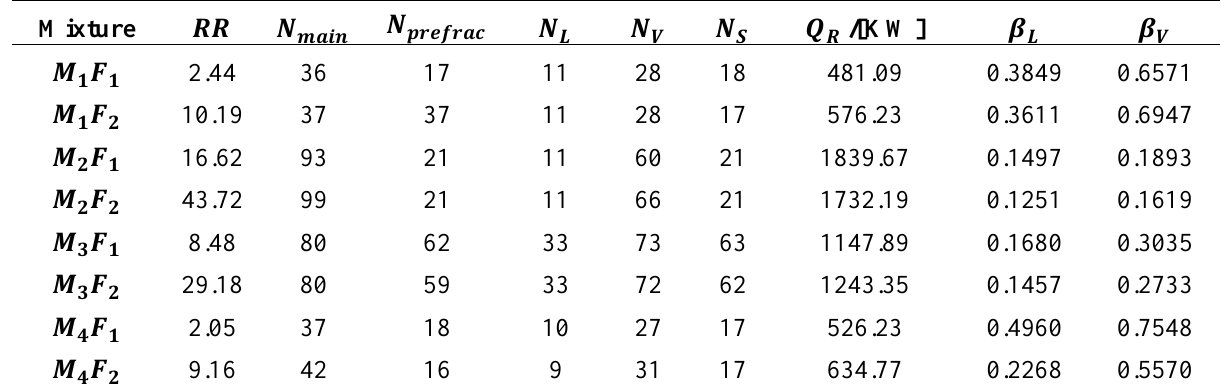
Table 5. Design structure of dividing-wall columns (DWCs) for different mixtures and